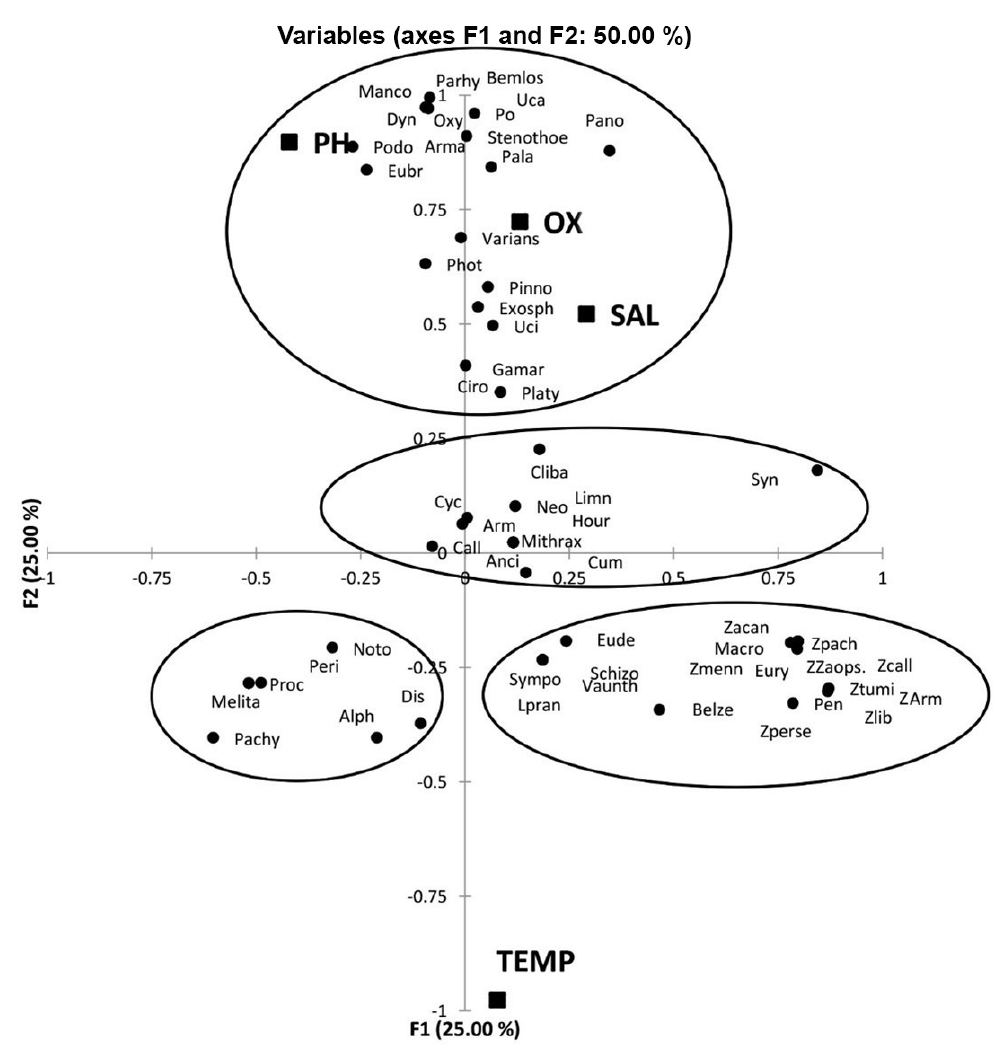
Figure 3. Canonical correlation analysis. Relationship between the abundance matrix of the stage-genera and the averages of the environmental variables. Stage-genera name abbreviations are shown in Tab.